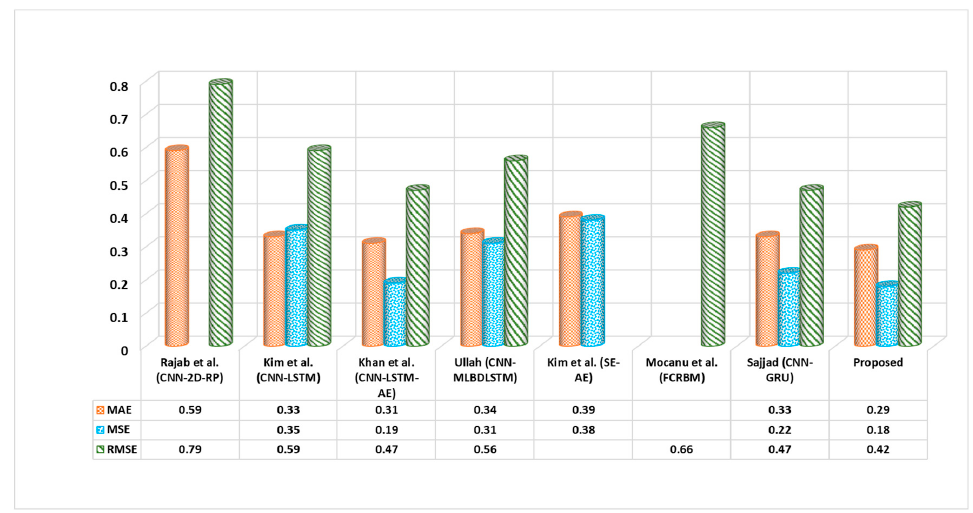
Figure 3. Performance comparison of the proposed model with the other state-of-the-art models over IHEPC dataset.